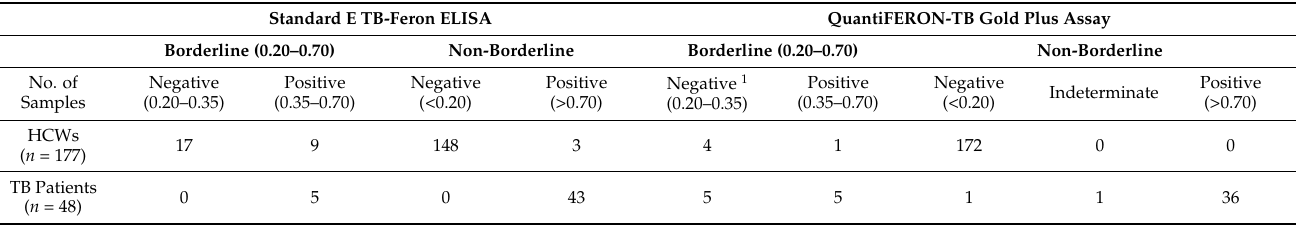
Table 2. Distribution of 225 samples with respect to the borderline range (0.20–0.70 IU/mL) in Standard E TB-Feron ELISA and QuantiFERON-TB Gold Plus assays.